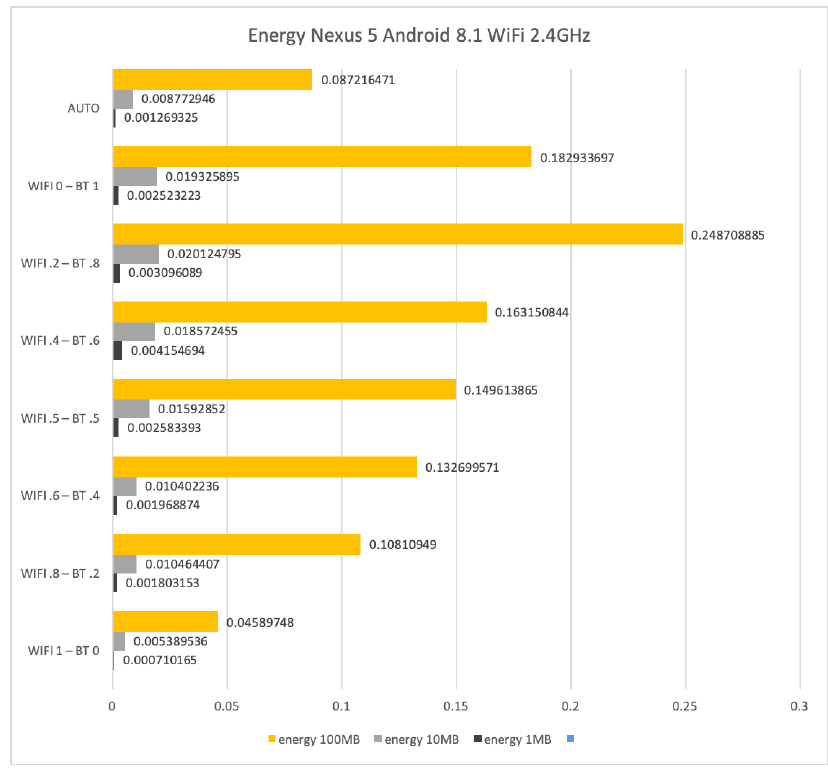
Figure 17. WiFi at 2.4 GHz and Bluetooth energy consumption results for the LG Nexus 5 with Android